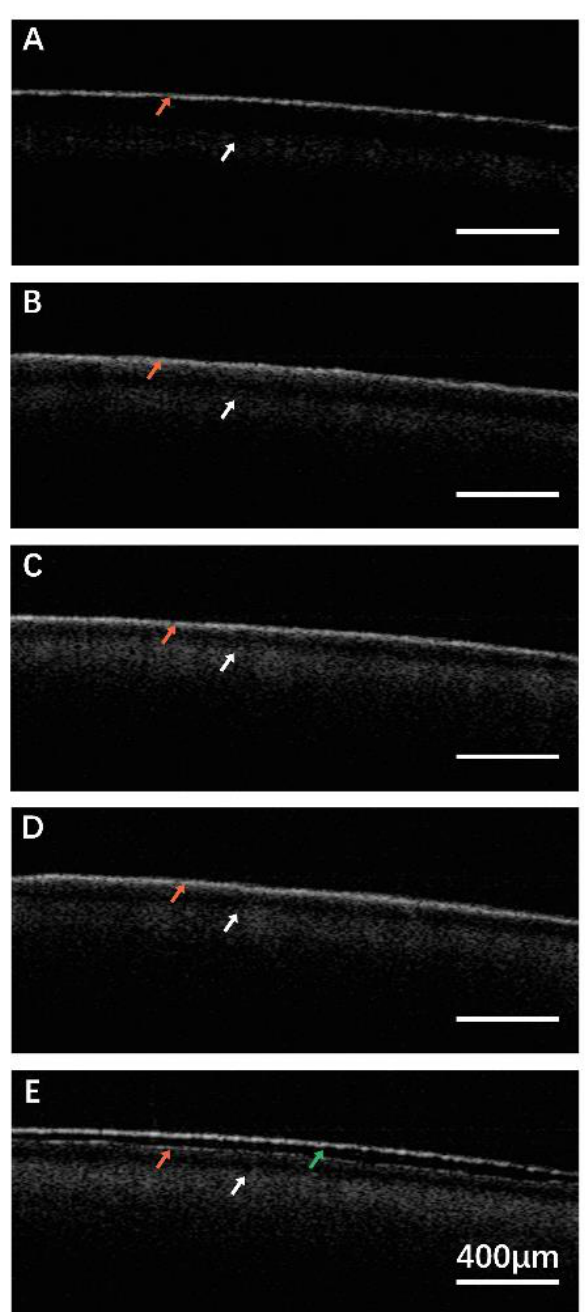
Figure 2. The OCT scanning images of each step. ( A ) Step 1: the surface of the incisor was clean; ( B ) Step 2: 37% phosphate etching agent was evenly applied to the incisor for 15 min, after which the surface was clean and dried; ( C ) Step 3: Icon-Etch was smeared evenly on the surface of incisor for 30 s, after which the surface was clean and dried; ( D ) Step 4: Icon-Dry was smeared evenly on the surface of incisor and kept for 1 min, after which the surface was dried; ( E ) Step 5: Icon-Infiltrant was smeared evenly on the surface of maxillary incisor for 1 min and light-cured for 40 s. Red arrow: the surface of the enamel. White arrow: enamel-dentinal junction (EDJ). Green arrow: resin layer. Scale bar is 400 μm.